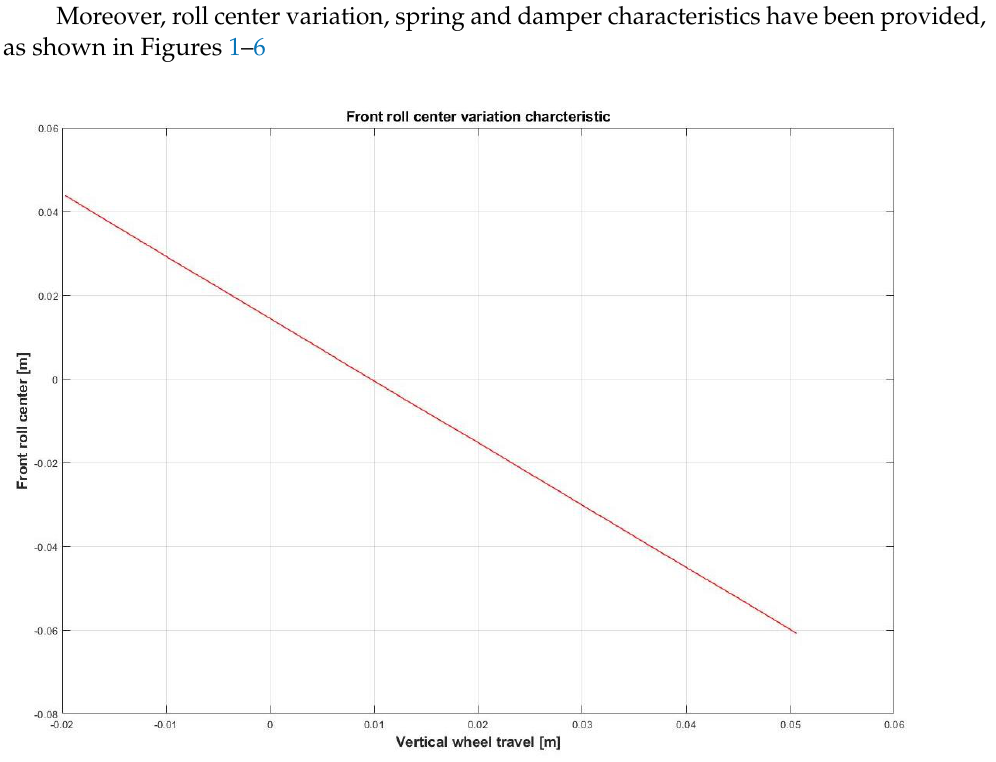
Figure 1. Front roll center variation